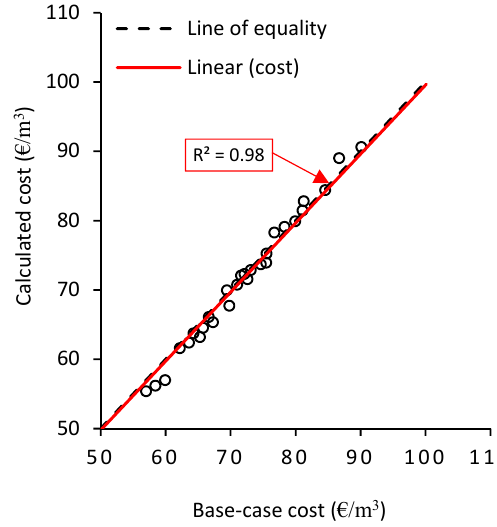
Figure 6. Base-case cost versus calculated cost.